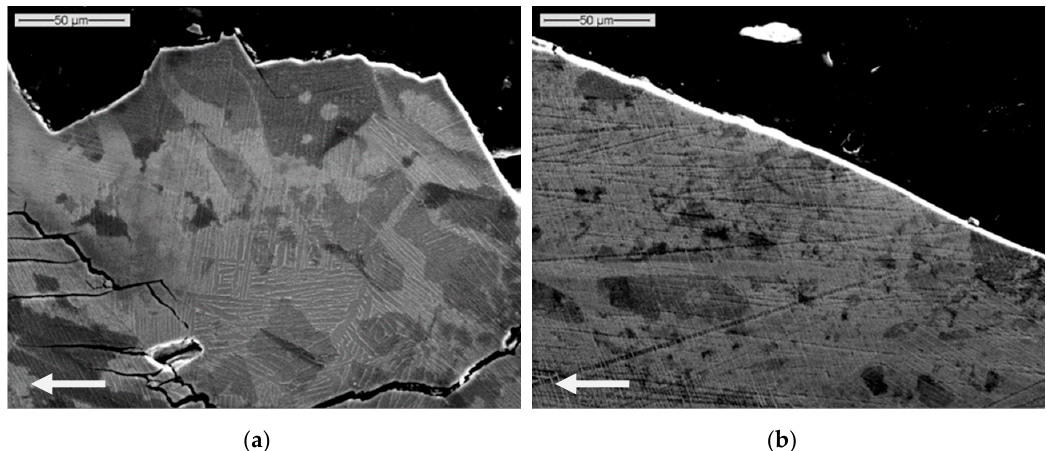
Figure 11. Crack path at mid-thickness before ( a ) and after ( b ) transition, respectively at Δ K = 20 MPa √ m and at Δ K = 40 MPa √ m, T β + 75 °C for 1 h 30 min heat treatment, propagation according to the arrow.